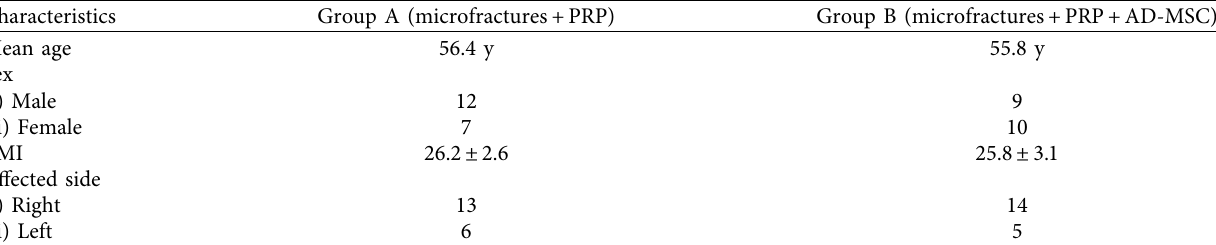
Table 1: Demographic characteristics of the two cohorts: group A: microfractures+PRP injection; group B: microfractures+PRP and AD- MSC injections.